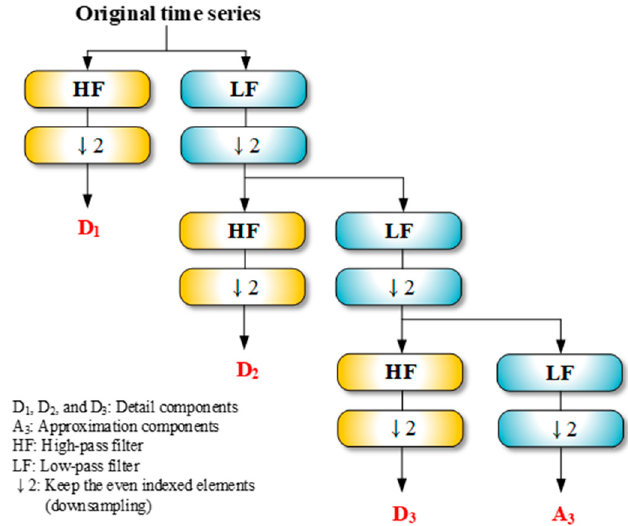
Figure 1. Structure of standalone soft computing models.